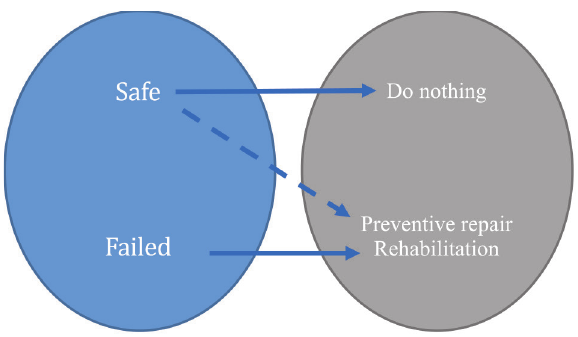
Figure 3. SOM approach with two-levelled service